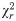
Results from reweighting the simulation with original force field parameters.(A) Fit to SAXS data, before (black) and after reweighting at θ = 150 (cyan), θ = 500 (green), and θ = 5000 (purple). (B) χr2 vs. ϕeff for selection of θ. (C) Calculated Rg during the simulation, including mean value (black), experimental Rg from SAXS (red) and mean Rg from the reweighted ensembles (green). Corresponding histograms in the right panel. (D) Calculated D13 before and after reweighting.